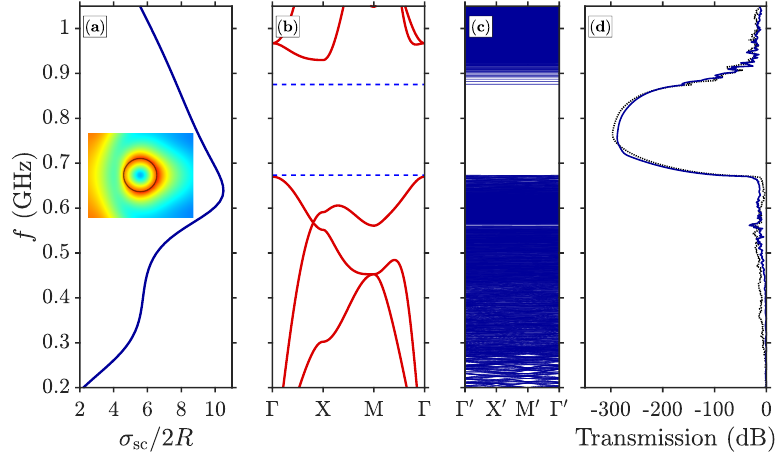
Figure 3. In-plane modes. ( a ) Scattering cross section of a single Pb (infinite) cylinder in epoxy. The magnitude of the elastic field for excitation from the left with a shear plane wave at 0.64 GHz is shown in the inset (black circle denotes the position of the cylinder). ( b ) The 2D band structure of the periodic crystal of Pb in epoxy. The horizontal broken lines denote the band gap edges of the HDPS. ( c ) The 2D band structure of the HDPS. ( d ) Transmission of the HDPS for the longitudinal (solid line) and transverse (dashed line) incident plane